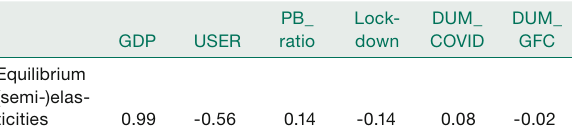
Table 1 Equilibrium